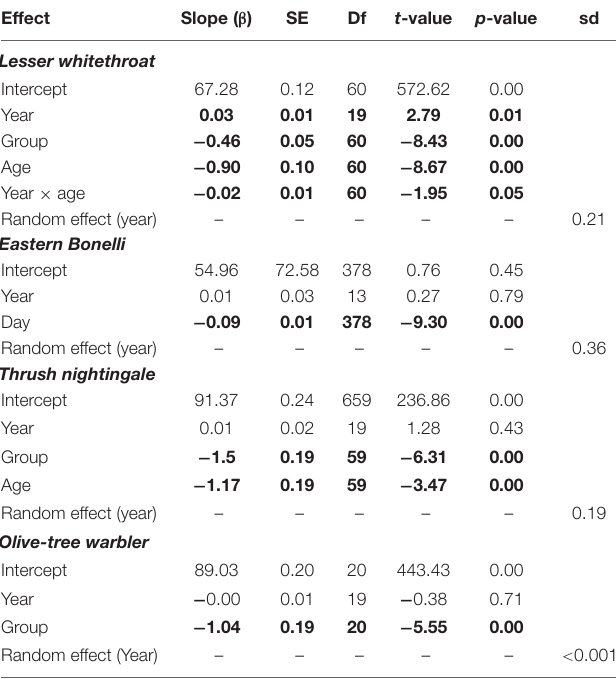
TABLE 2 | Results of linear mixed-effect model testing the effect of year, arrival phase (early or late; “Group”) and Age (Second year or adults; where known), with Year also as a random effect, on the average wing length of the studied species during spring migration in Jerusalem, Israel during the study period